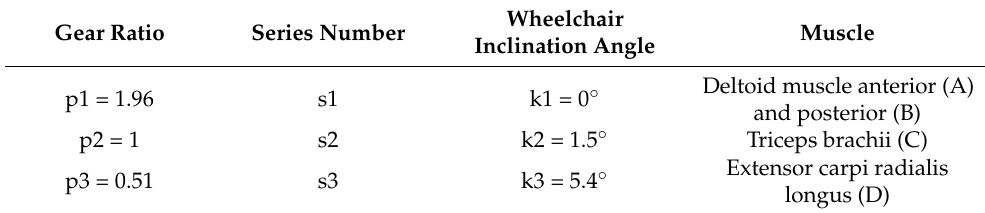
Figure 5. Diagram of carried out experiments; A1 — patient preparation, A2 — normalization, A3 — placing on the stand, B1 — test start, B2 — break, B3 — test variant change and B4 — test end. The test consisted of performing a series of 30 propulsion phases, i.e., pushing off the Table 1. Variants, markings and input values used in wheels of a wheelchair. This number was selected so that it was possible to carry out all